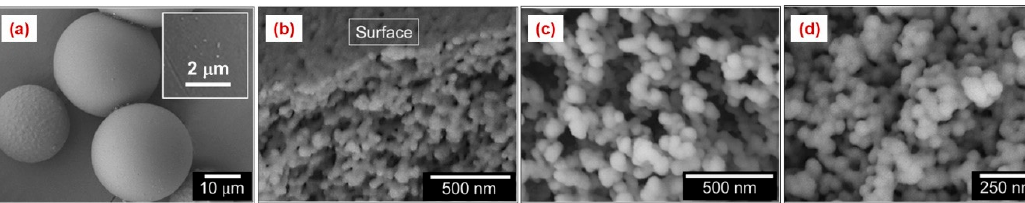
Figure 17. SEM image of: ( a ) PBO aerogel microparticles (inset: surface of the sphere), ( b ) fractured surface of PBZ aerogel microparticles, and ( c , d ) ensemble of spherical polybenzoxazine domains that formed the internal structure of aerogel microparticles and monolith, respectively. Adapted with permission from Ref. [54]. Copyright 2016 American Chemical Society.